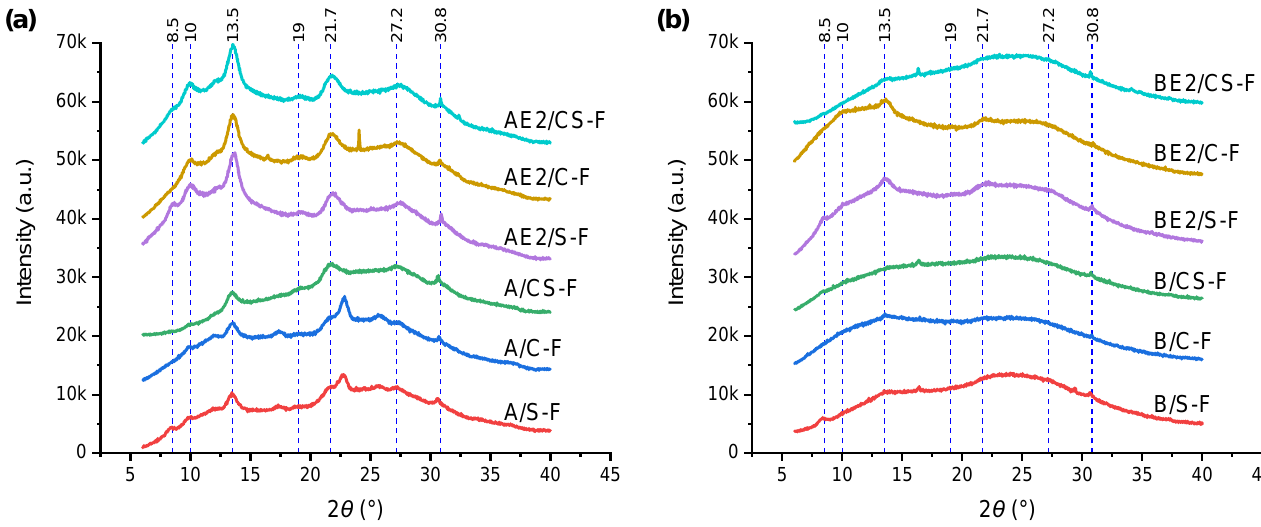
Figure 3. X-ray diffractograms for the different bionanocomposite films: ( a ) chitosan matrix; and ( b ) chitosan/CMC matrix. The reference lines indicate characteristic peaks for sepiolite (SPT) (8.5°) and A-F (the rest) [13].